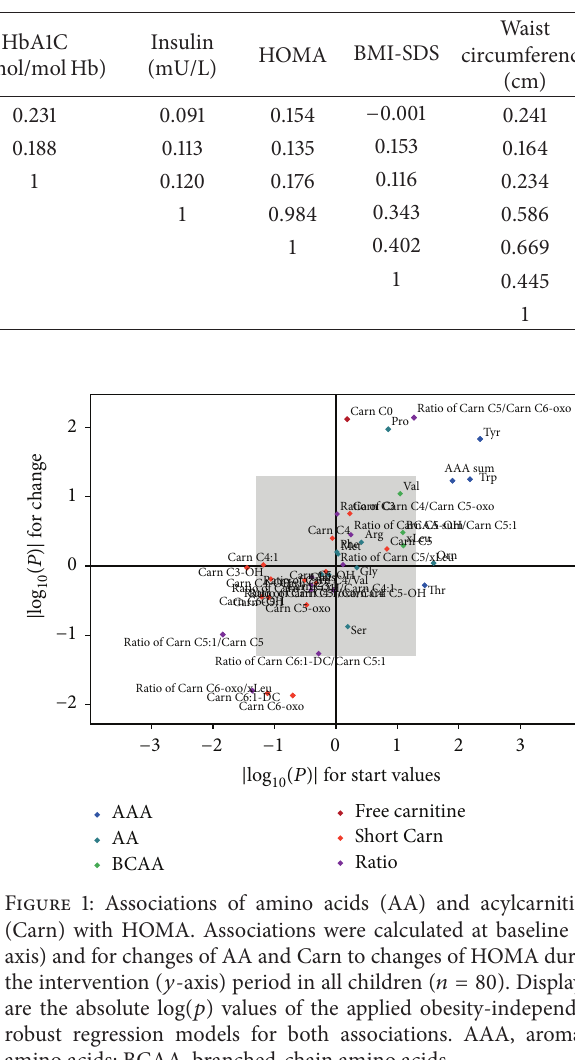
Table 2: Spearman correlation coefficients of markers of insulin homeostasis in all obese children ( 𝑛 = 80 ) at baseline.